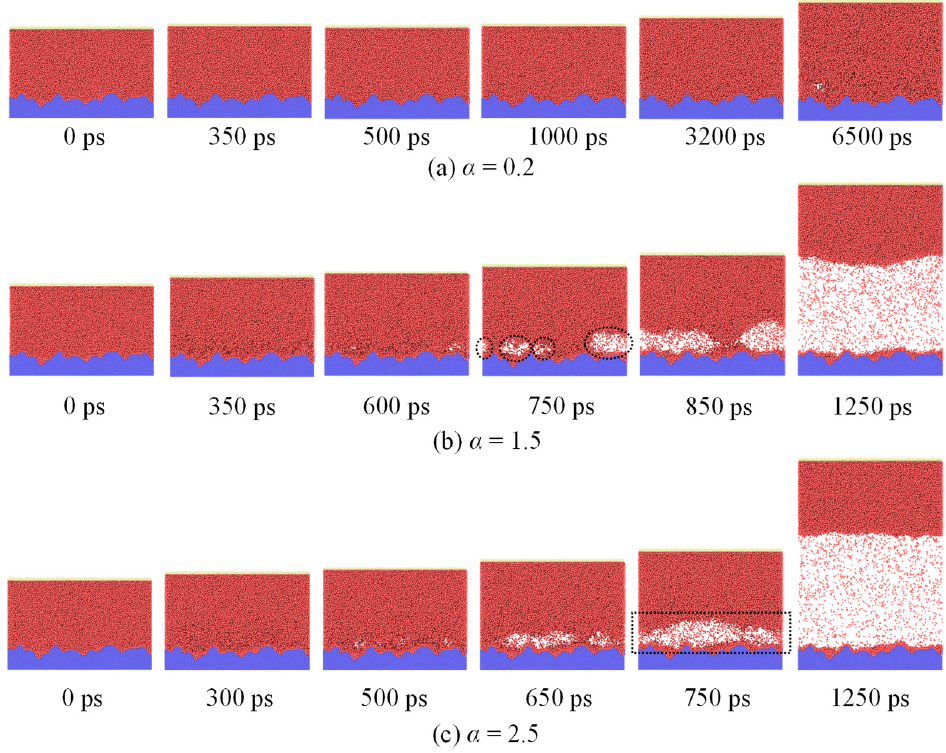
Figure 4. Snapshots of three typical phase–change processes of liquid argon on nanostructured surfaces with different solid–liquid interactions. ( a ) α = 0.2; ( b ) α = 1.5; ( c ) α = 2.5.